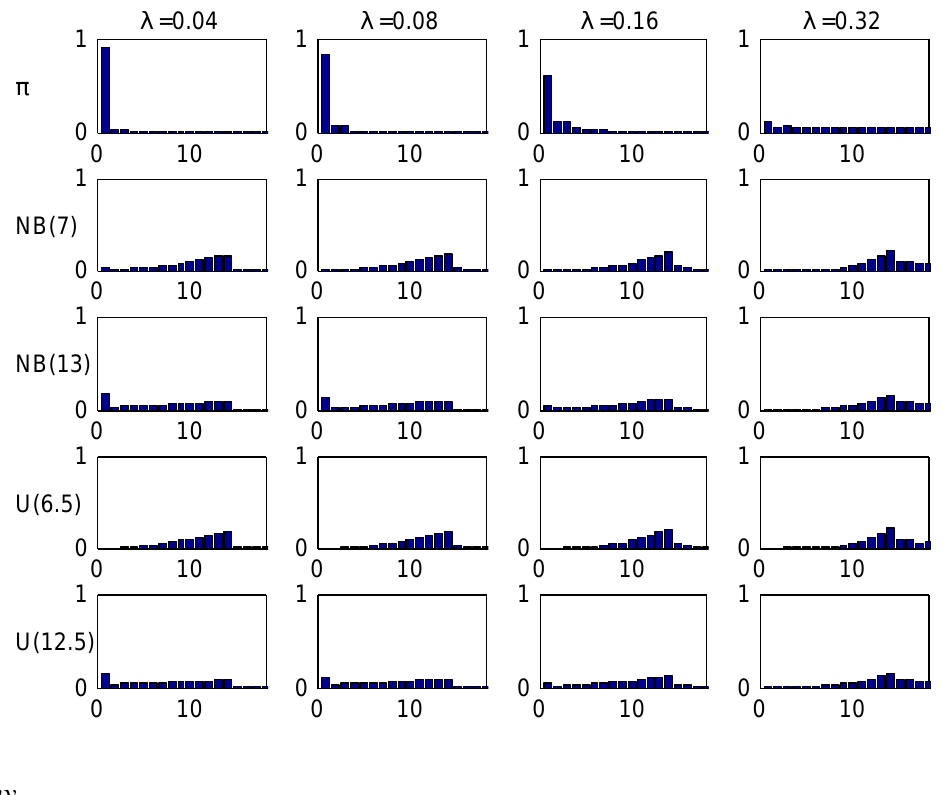
Figure 8. Stationary and age-corrected distributions,